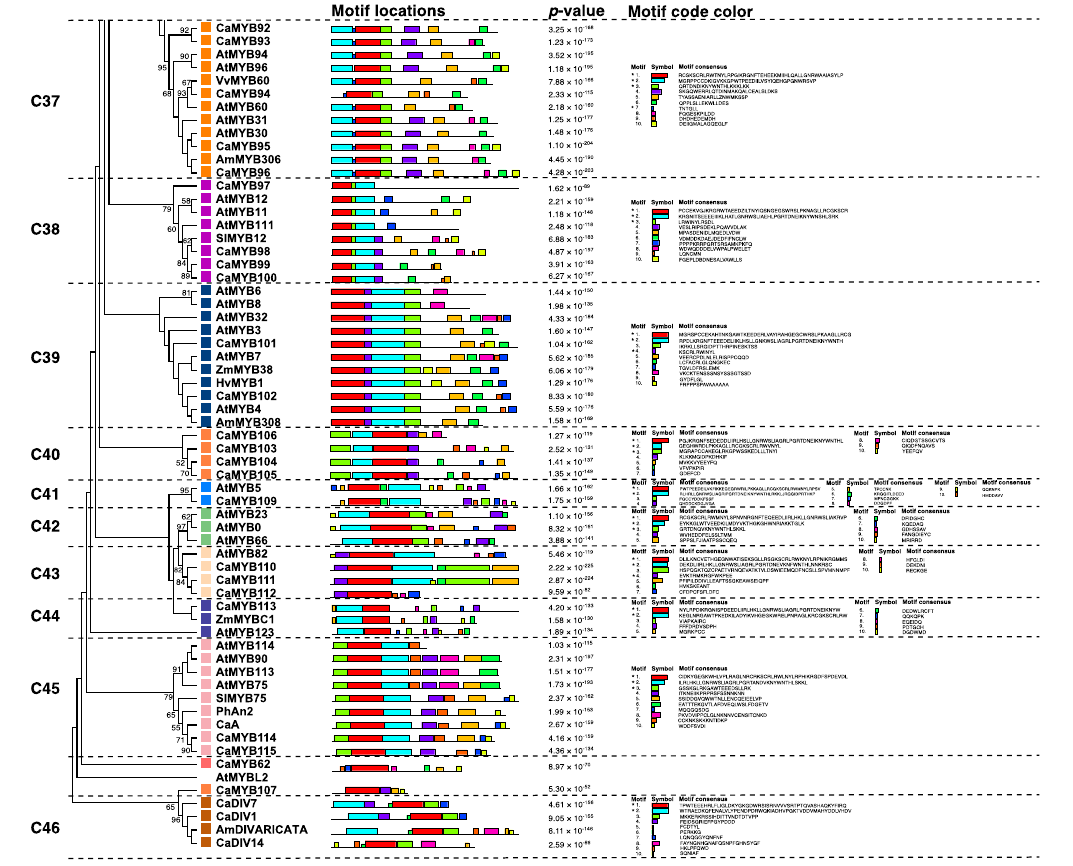
Figure 4. Schematic representation of motif composition of CaMYB subgroups. Each subgroup was analyzed using the MEME motif-detection software. The length of the solid line represents the length of the protein sequences. Colored boxes represent different motifs. Asterisks (*) indicate motifs containing the conserved MYB domain sequence. Ca: Capsicum annuum ; Cb: Capsicum baccatum ; Cc: Capsicum chinense ; At: Arabidopsis thaliana ; Sl: Solanum lycopersicum ; St: Solanum tuberosum ; Nt: Nicotiana tabacum ; Am: Antirrhinum majus ; Os: Oryza sativa ; Mm: Mus musculus ; Hv: Hordeum vulgare ; Zm: Zea mays ; Ph: Petunia hybrida ; Vv: Vitis vinifera . The protein IDs are listed in Tables S1 and S2.